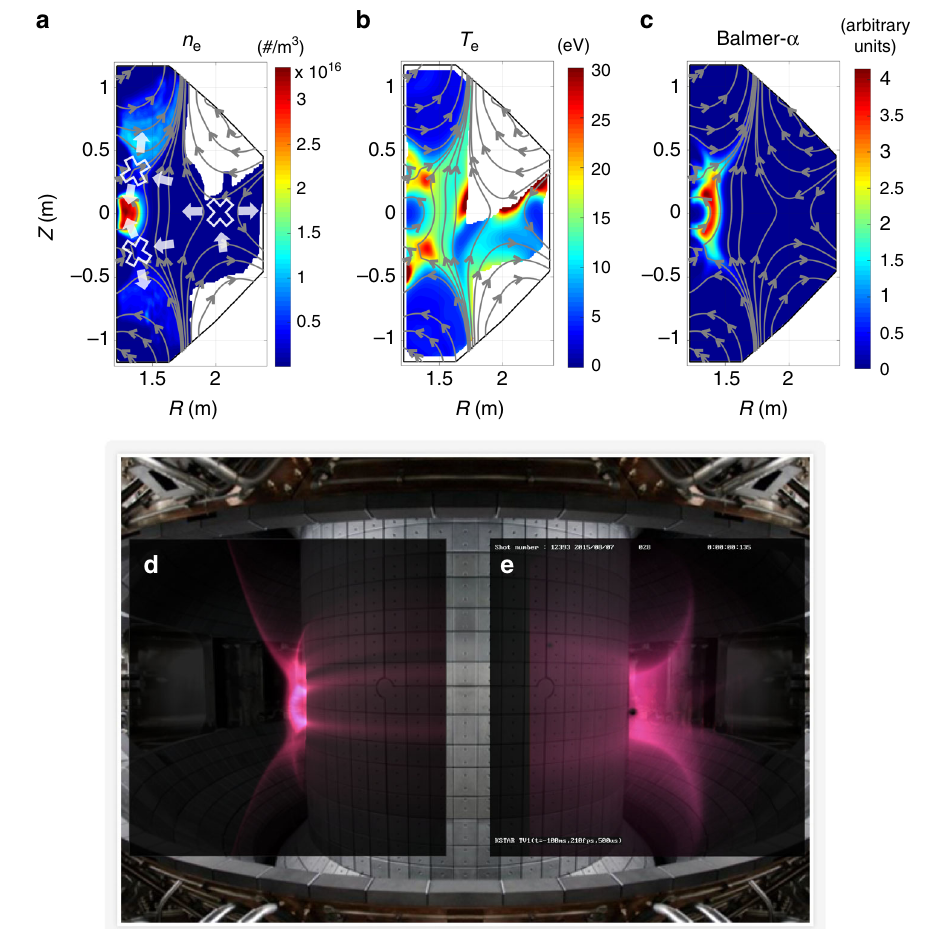
Fig. 10 Comparison between BREAK simulation results and KSTAR experiments. Simulation results of a electron density, b electron temperature, and c Balmer- α line emissions at t = 36 ms of the KSTAR reference breakdown scenario. Bold white X symbols and white arrows in a indicate the locations of X-points and the directions of the mean ExB fl ows, respectively. d A synthetic diagnostic of the Balmer- α line emission in the simulation is compared with e an experimental visible camera image from